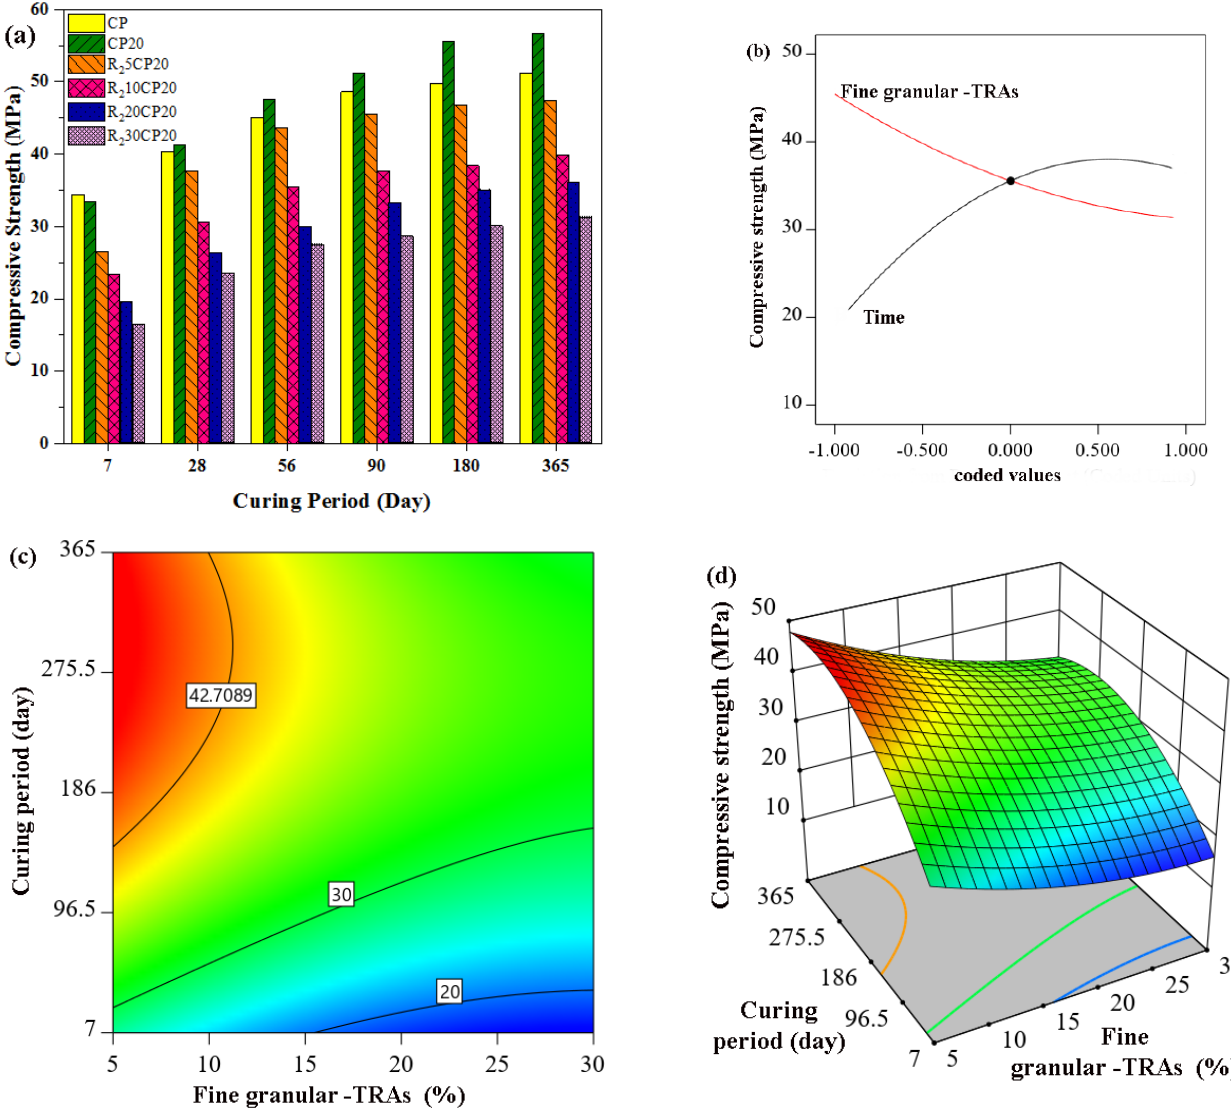
Figure 8. Effect of POFA concrete containing fine granular-TRAs on compressive strength, ( a ) Ex- perimental work, ( b – d ) RSM